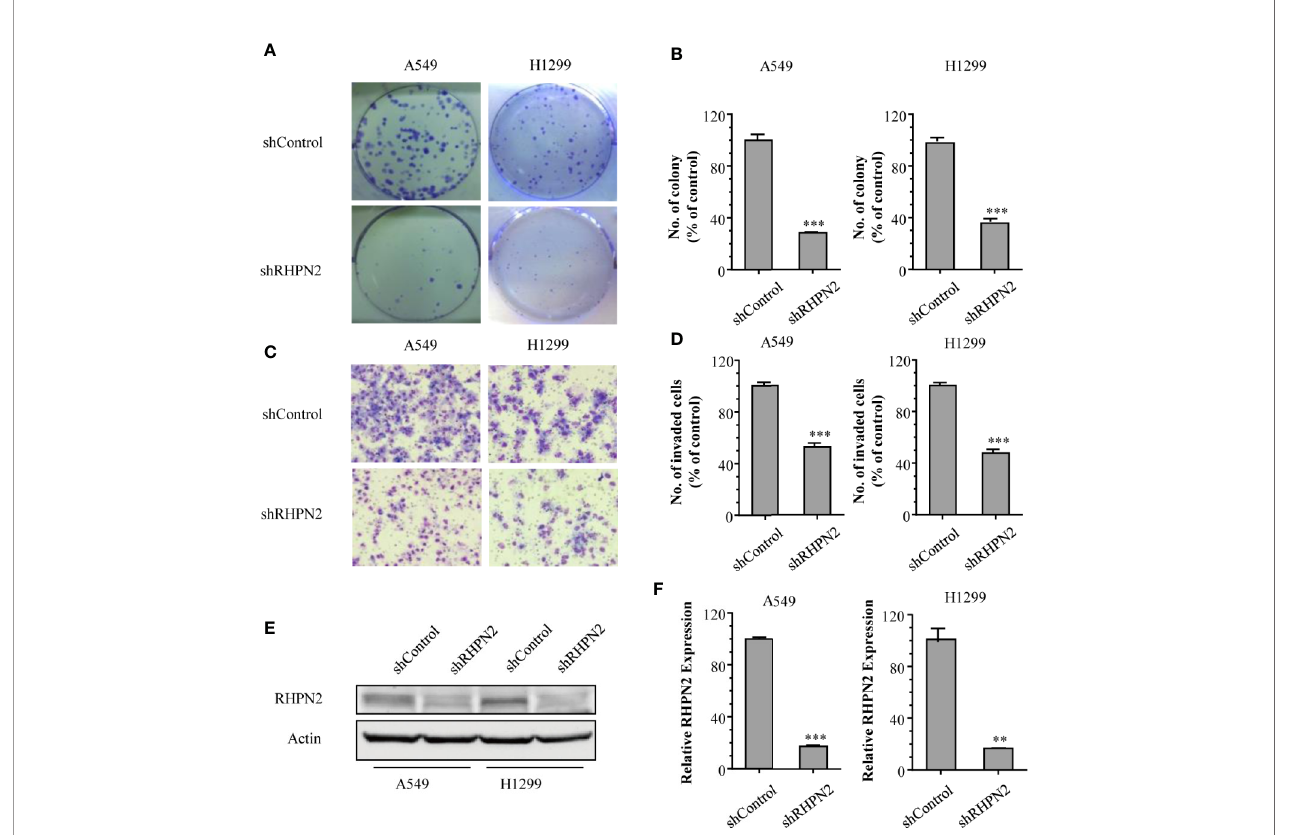
FIGURE 2 | RHPN2 is required for cell growth and in vitro invasion of lung cancer cells. (A, B) the clonogenic formation assay was performed to detect the growth of A549 and H1299 cells stably expressing shControl and shRHPN2. The representative images and quantitative results were shown in (A, B) , respectively. (C, D) Transwell invasion assay was used to examine invasive ability of A549 and H1299 cells. The representative images and quantitative results of invaded cells in A549 and H1299 cells were shown in (C, D) , respectively. (E, F) the reduced expression of RHPN2 in RHPN2-depleted A549 and H1299 cells was con fi rmed by immunoblotting (E) and RT-qPCR (F) . The data were representative of three independent experiments and were expressed as mean ± SD. ** p < 0.01 and *** p < 0.0001 compared with control